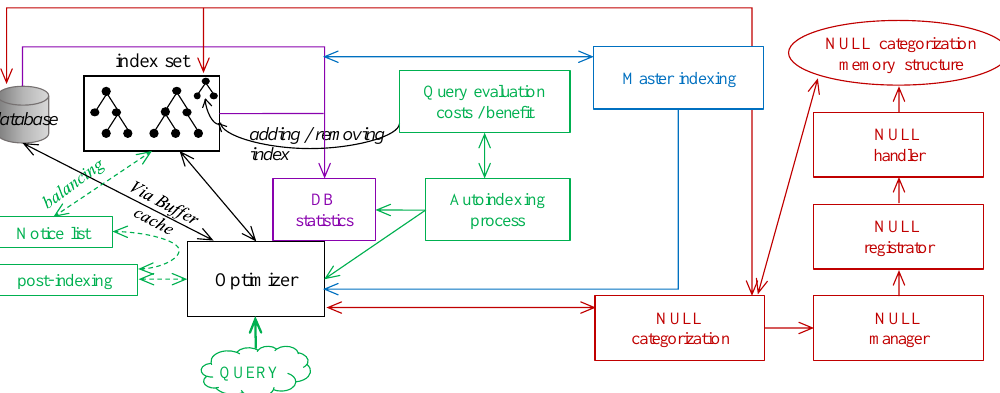
Figure 12. Data retrieval—complex